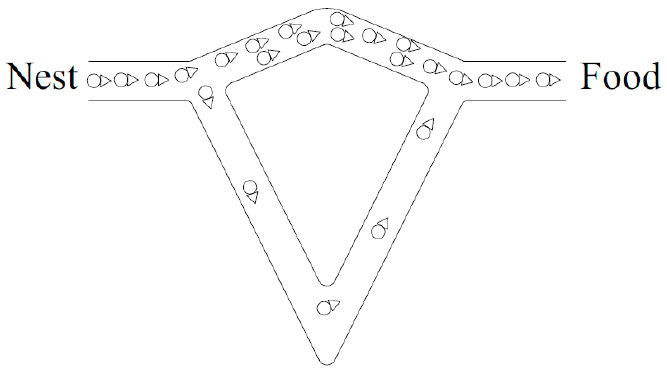
Figure 1. Cooperative search of ants using pheromone trails.